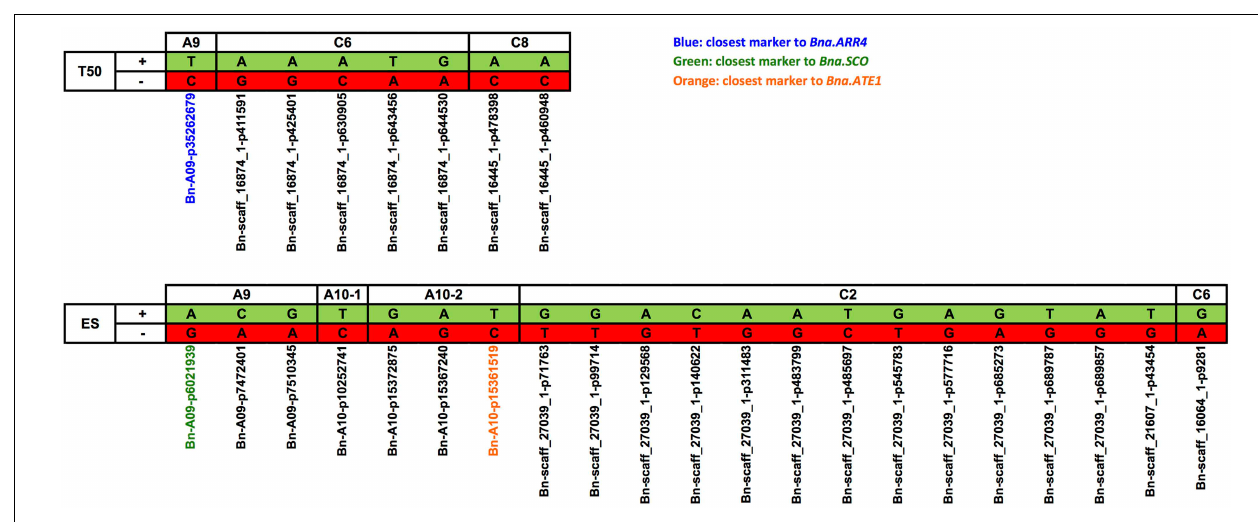
alleles with negative effect on trait performance ( − ) were shown in red. Corresponding marker names were listed below. T50, Time to reach 50% of germination; ES, Elongation speed of the